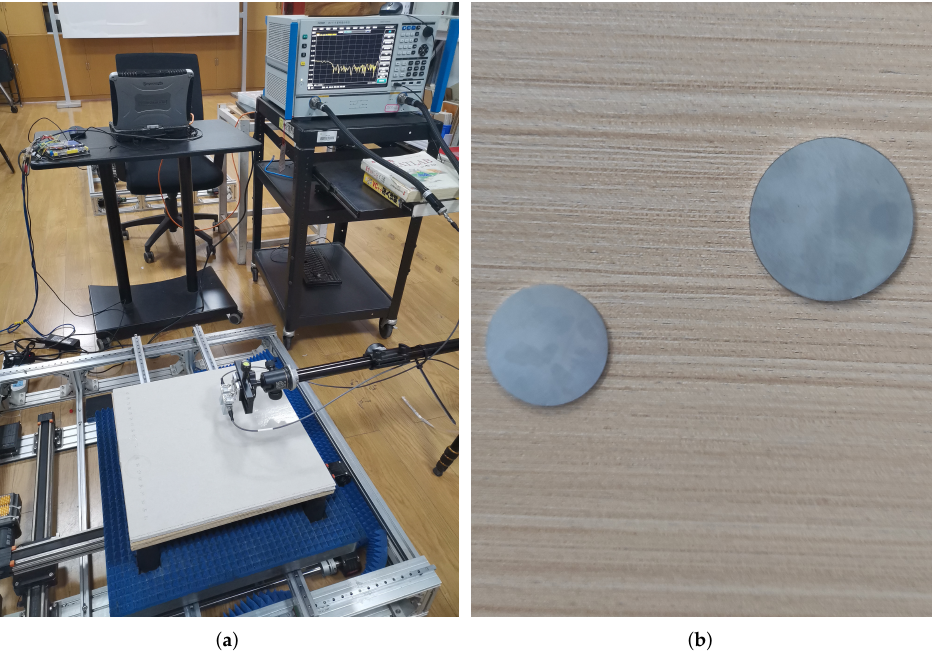
Figure 8. Photograph of measurement setup of Scene III. ( a ) View of the test scene. ( b ) Hidden